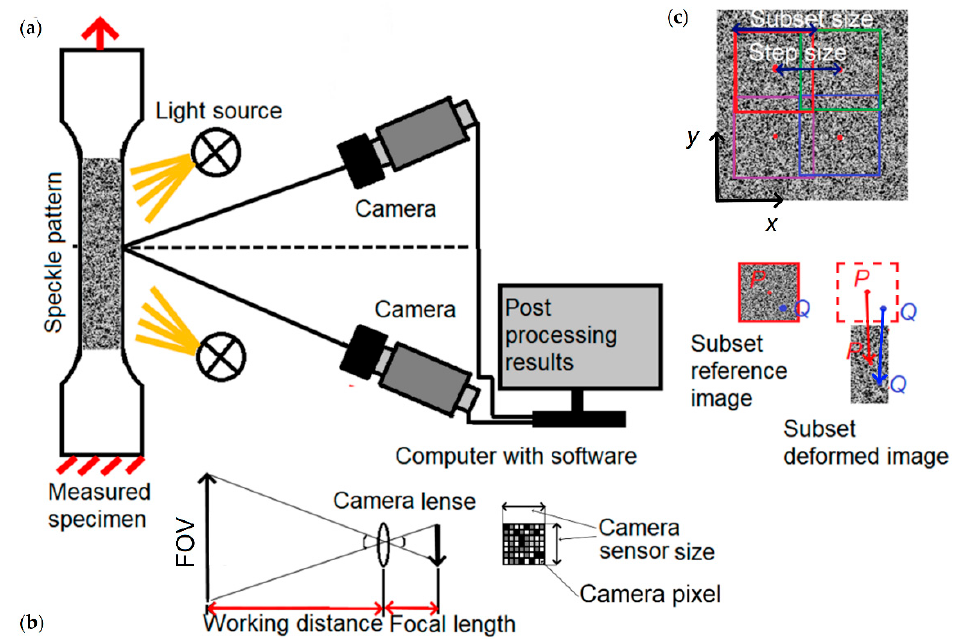
Figure 2. 3D DIC: ( a ) general experimental setup; ( b ) cameras and lenses parameters; ( c ) results post processing: subset tracking and displacement/strain calculation.